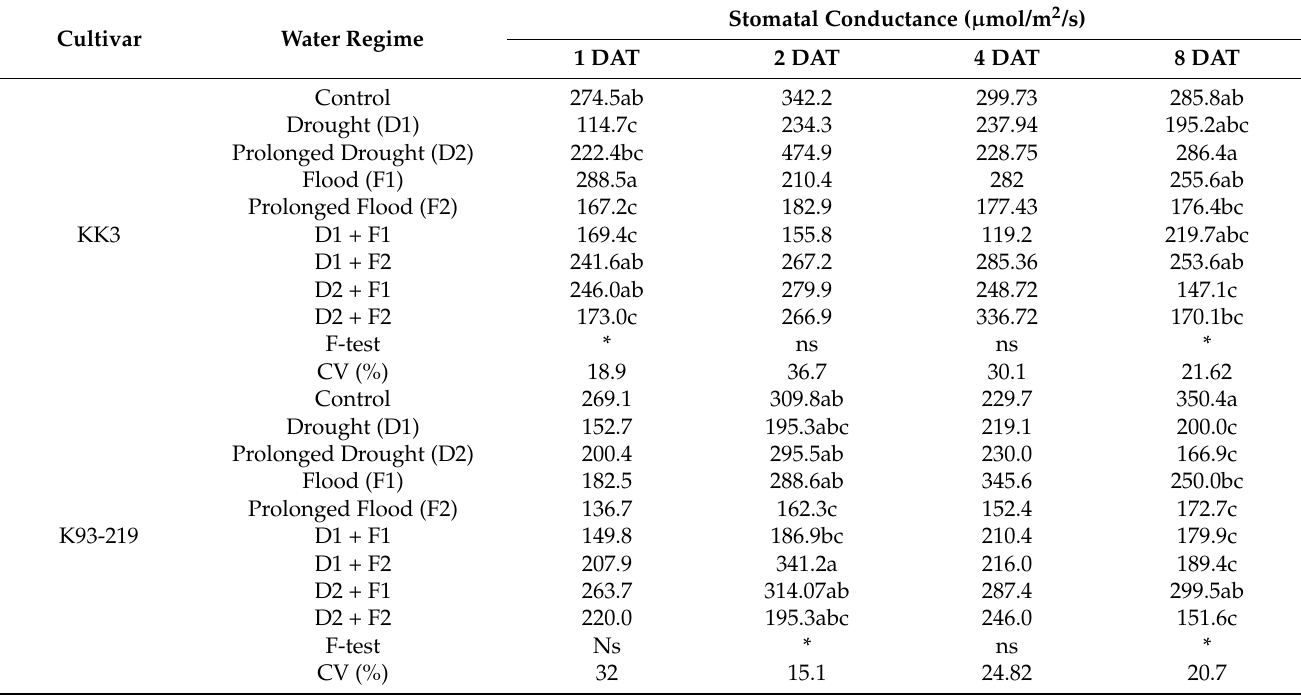
Table 1. Stomatal conductance (gs) of two sugarcane cultivars at 1, 2, 4, and 8 days after initiation of treatment (DAT) and harvest as affected by drought or flood treatment, Experiment 1.